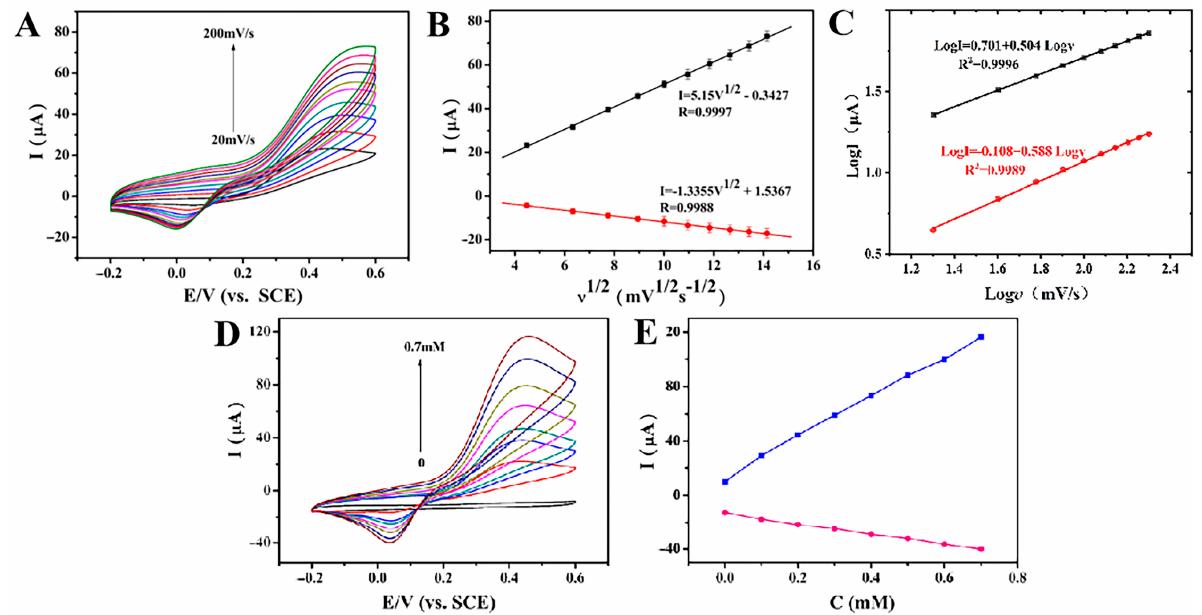
Figure 7. CV curves of AuNPs@COFs nanocomposites to 1 mmol/L ractopamine at different scan rates (20, 40, 60, 80, 100, 120, 140, 160, 180, 200 mV/s) in 0.1 mol/L PBS ( A ) and the relationship between peak current and square root of scan rate ( B ); corresponding logI vs. log v plots ( C ); CV curves of AuNPs@COFs nanocomposites for different concentrations of ractopamine (0, 0.1, 0.2, 0.3, 0.4, 0.5, 0.6 and 0.7 mmol/L) ( D ); linear relationship between ractopamine concentration and ractopamine peak current ( E ).